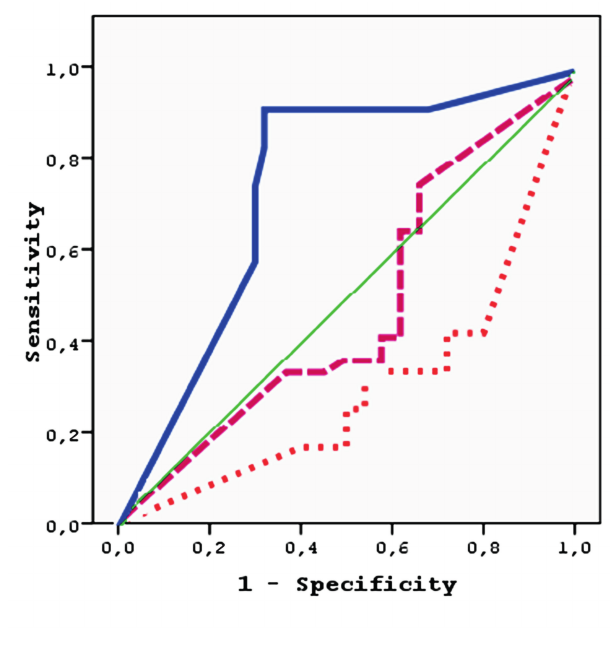
Figure 1 - Number of Leukocytes in Prostate Massage Fluids; Prostatitis, BPH, and Pca Relations (Straight line: prostatitis, Dashed line: BPH, Dots: